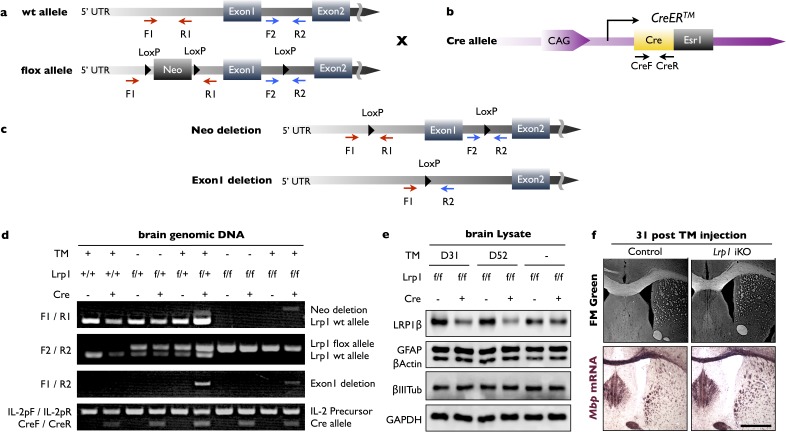
Generation of Lrp1 global iKO mice.(a) Lrp1 wildtype (wt) and conditional, LoxP flanked (floxed), alleles. The location of PCR primers used for genotyping, the neomycin cassette (Neo), and LoxP sites are shown. (b) For global inducible gene ablation, the CAG-CreERTM mouse line was used, in which the Cre recombinase is fused with a tamoxifen (TM)-responsive estrogen receptor (Ers1) and expressed under the control of a ubiquitous chicken β-actin-CMV hybrid (CAG) promoter. (c) Following TM administration, recombination can lead to deletion of Neo only or deletion of Neo and exon 1. (d) PCR genotyping of brain genomic DNA. Analysis of PCR products amplified from of Lrp1+/+ mice with (+) or without (-) the cre allele; Lrp1flox/+ mice ± Cre allele and ±TM treatment; Lrp1flox/flox mice ± Cre allele and ±TM treatment. The F1/R1 primer pair amplifies a ~300 bp PCR product from the wt Lrp1 allele and a ~400 bp PCR product if the Neo cassette is deleted. The F2/R2 primer pair amplifies a 291 bp PCR product from wt Lrp1 allele and a 350 bp PCR product from Lrp1 flox allele. The F1/R2 primer pair amplifies a ~500 bp PCR product if exon1 in deleted. The IL-2pF/IL-2pR primer pair amplifies a 324 bp fragment and served as internal PCR quality control. The CreF/CreR primer pair amplifies a ~200 bp PCR product if Cre is present. (e) Immunoblots of whole brain lysates prepared from Lrp1flox/flox;CAG-CreERTM mice 31 and 52 days after TM (+) or vehicle (-) treatment. Representative blots probed with anti-LRP1β, anti-GFAP, anti-β-actin, anti-β-III tubulin, and anti-GAPDH. (f) Coronal-sections of adult Lrp1 control and iKO mice 31 days after i.p. TM administration. Sections were stained with FM Green or probed for Mpb mRNA by in situ hybridization. Scale bar = 1 mm.